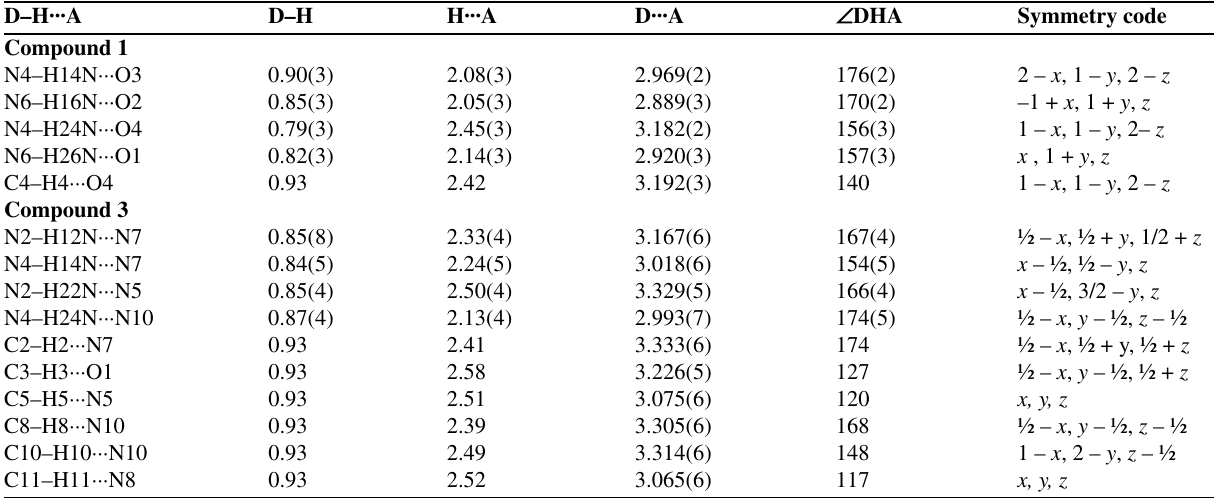
Figure 1b. Crystal packing of 1 viewed down the a axis indica- ting hydrogen bonding interactions as dashed lines. The inset points at typical head-to-head amide synthon observed in the cry- stal structure of 1 . Table 3. Hydrogen bonds (Å and °) for compounds 1 and 3